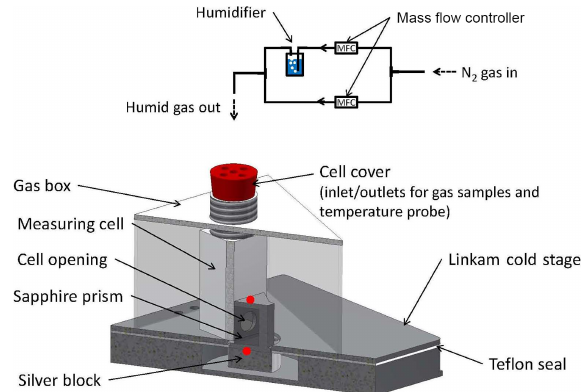
Figure 2. The temperature-controlled environmental chamber con- figuration and humidification and temperature sensors. The red dots are the position of the sample temperature sensors. There is a tem- perature sensor inside the measuring cell (not